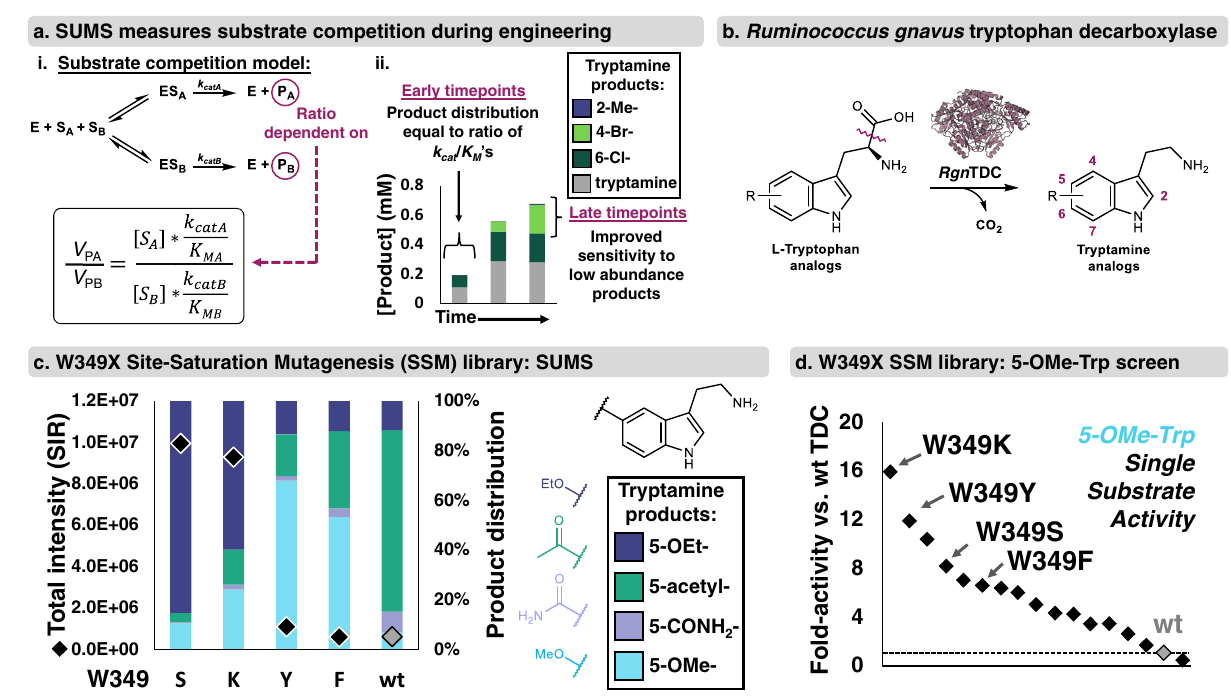
Fig. 2 | Substrate multiplexed screening (SUMS)-based engineering of Rumi- noccus gnavus tryptophan decarboxylase ( Rgn TDC). a i. Substrate competition modelwith equation describing relative rates of productformation. ii. Timecourse ofasubstratemultiplexedreactionof Rgn TDCwith2-Me-,4-Br-,6-Cl-,andTrp.Full reactionconditionsfoundinSupplementaryFig.42. b Generalreactionof Rgn TDC, with the labile bond highlighted. R =halo, alkyl, nitro, ether, etc. See ref. 40 for detailedscopeofthewild-typeenzyme. c SUMSresultsfromaW349Xlibraryusing